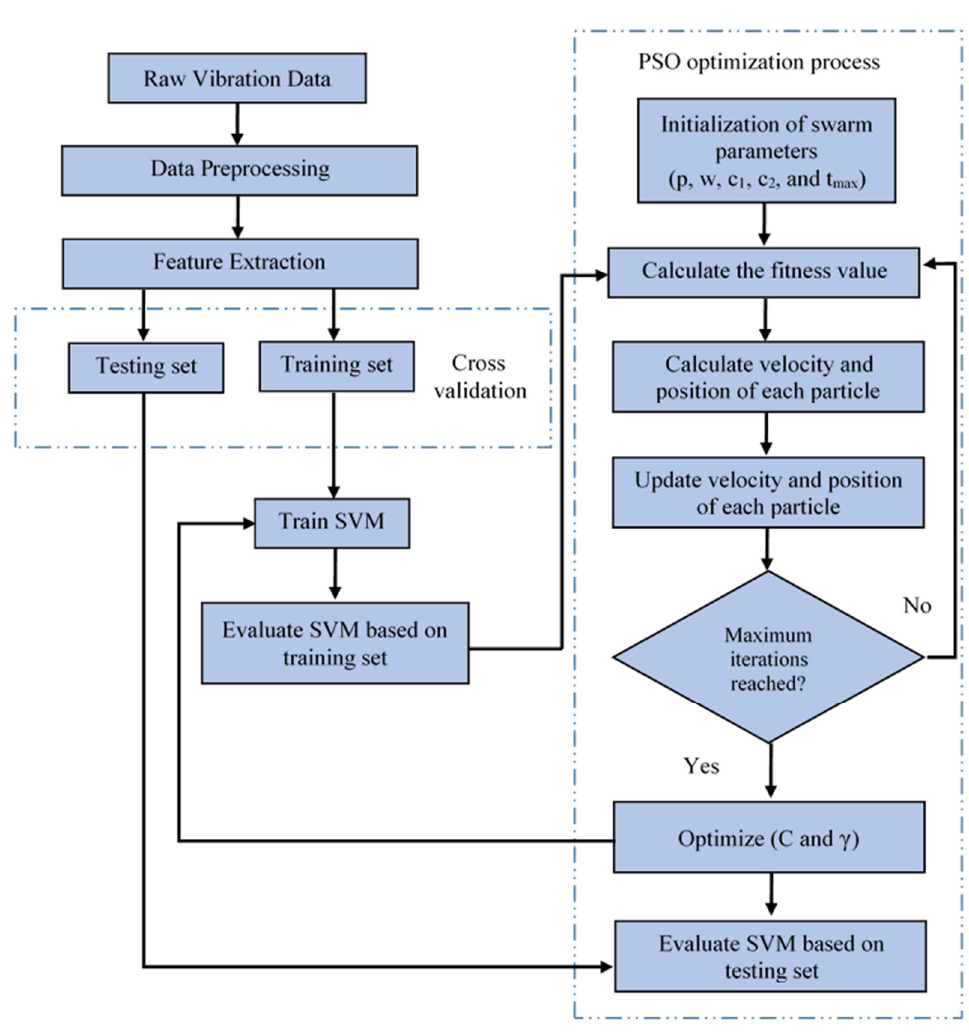
Figure 4. Flow diagram of PSO–SVM algorithm.